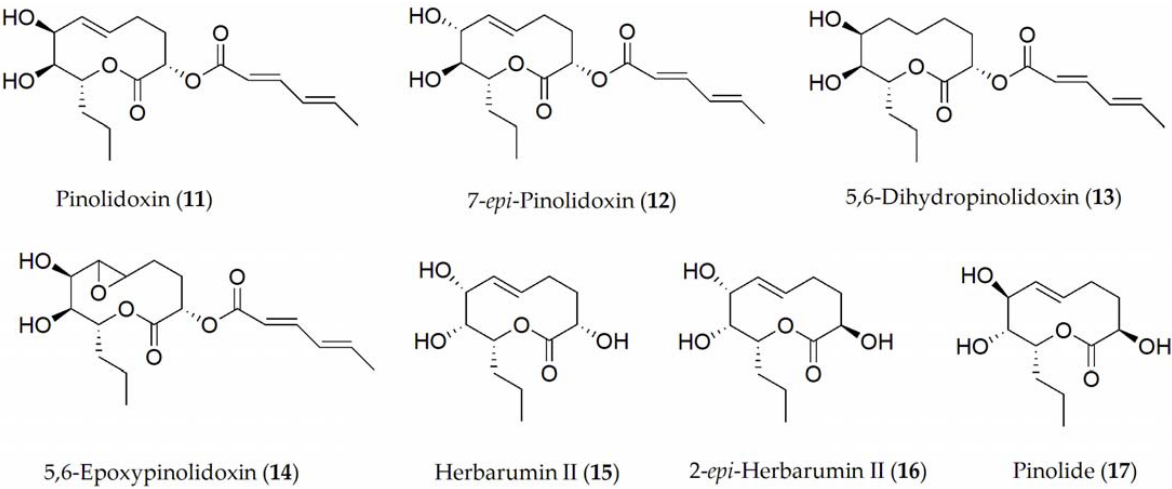
Figure 2. Phytotoxins isolated from Ascochyta pinodes .